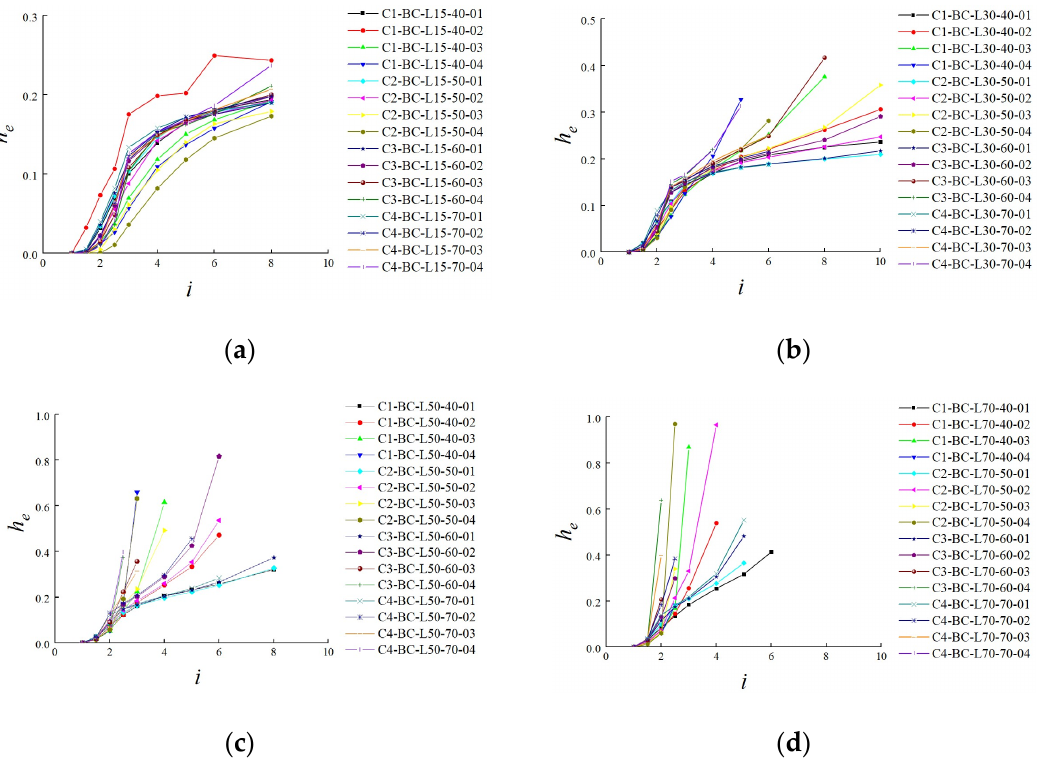
Figure 13. Relationship between equivalent viscous damping coefficients and load step. ( a ) λ = 15; ( b ) λ = 30; ( c ) λ = 50; ( d ) λ = 70.